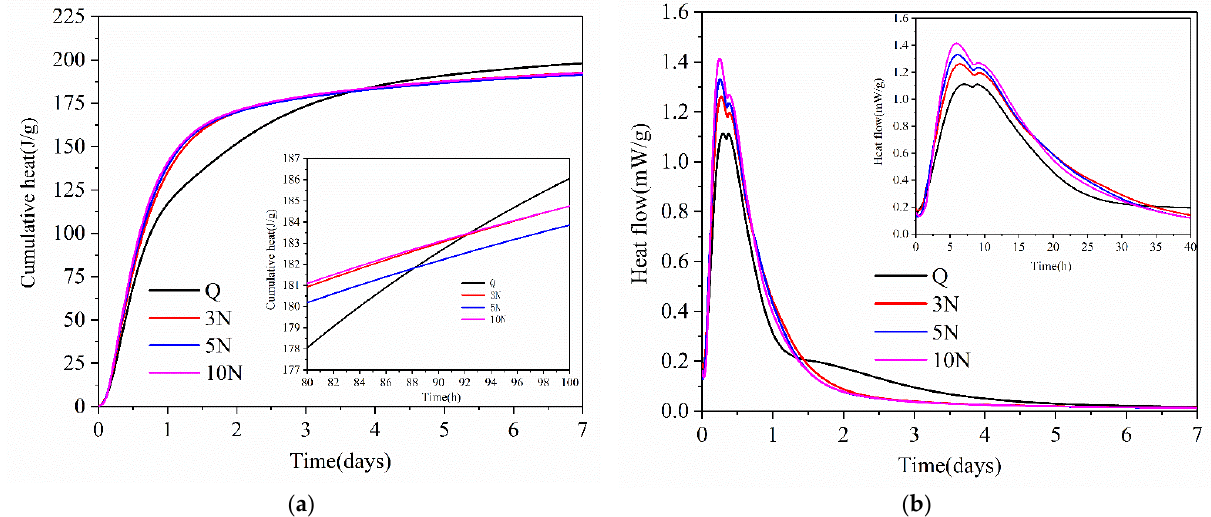
Figure 3. Effect of hydration heat of different content of Na 2 SO 4 cementitious material ( a ) is the heat release curve of hydration; ( b ) is the heat release rate of hydration.